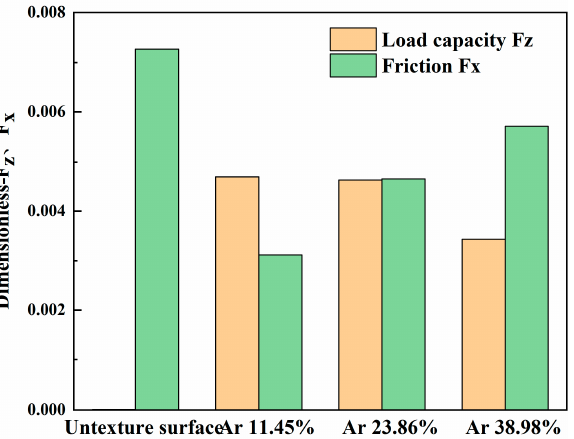
Figure 18. The bearing capacity and frictional force of the dimensionless oil film on the upper wall with di ff erent texture area occupancies.